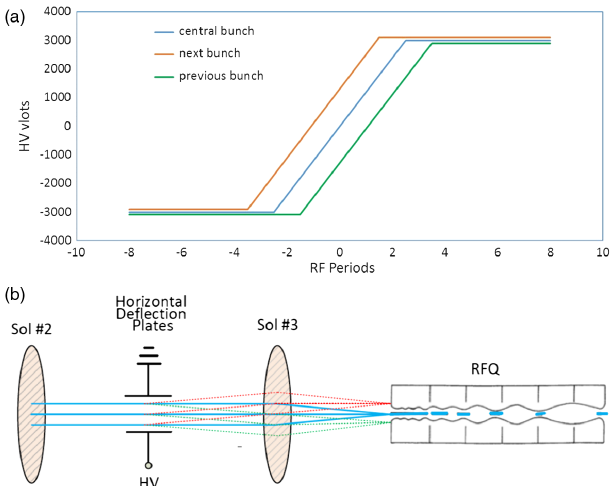
FIG. 3. Schematic diagram of the single bunch selection mechanism: (a) Deflection electric field felt by beam passing deflection plates for central bunch and “ previous ” and “ next ” bunches. (b) Diagram of undeflected and deflected beam focused onto RFQ, blue corresponding to central bunch, and green and red corresponding to previous and next